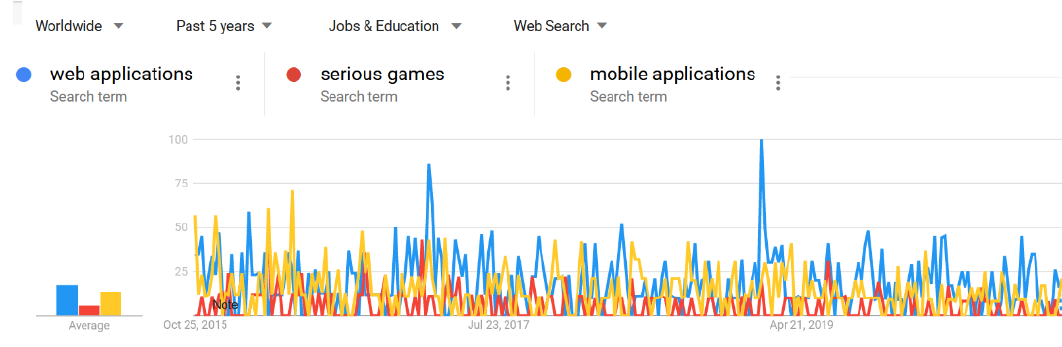
Figure 1. Trend of web-based serious games [2].